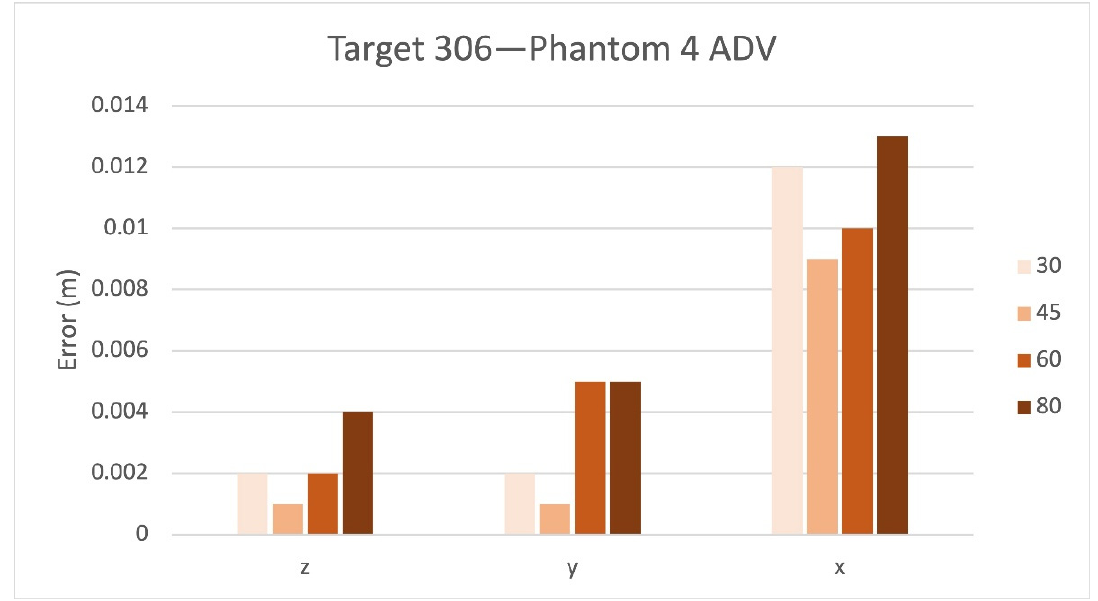
Figure 7. Residuals from the Phantom 4 on CkP 306